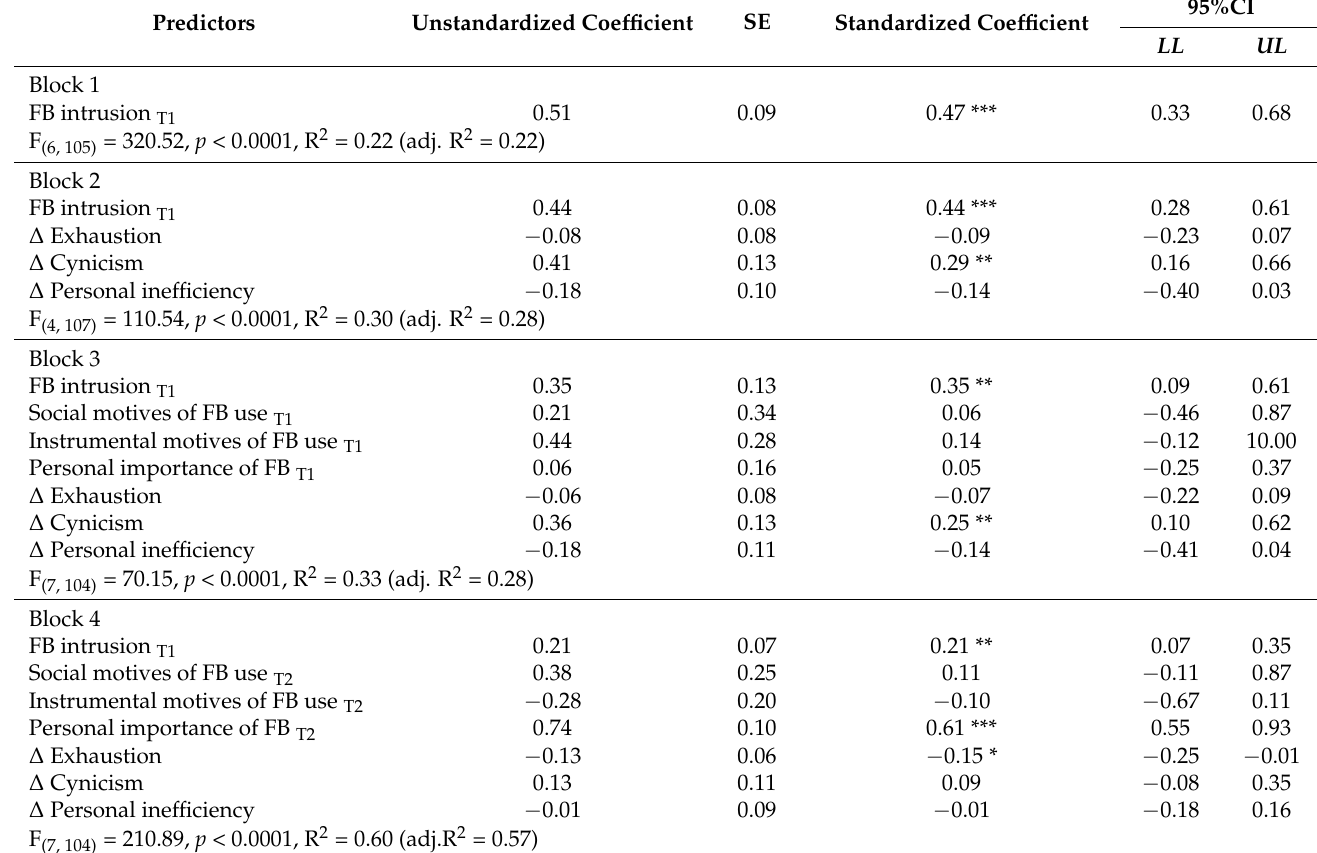
Table 1. Predictors of time 2 FB intrusion—multiple regression analysis